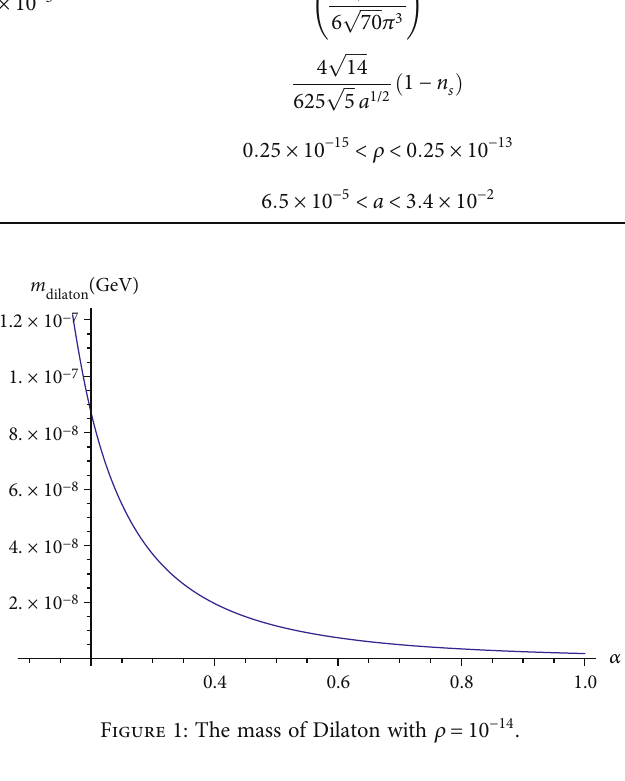
Figure 1: The mass of Dilaton with ρ = 10 − 14